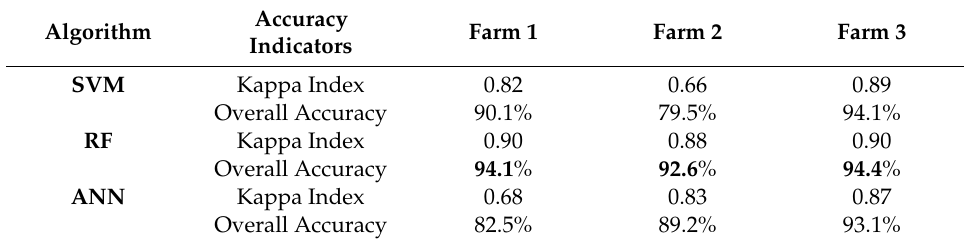
Table 3. Kappa Index and Overall Accuracy for Support Vector Machine (SVM), Random Forest (RF) and Artificial Neural Networks (ANN) algorithms using single epoch classification applied to the three